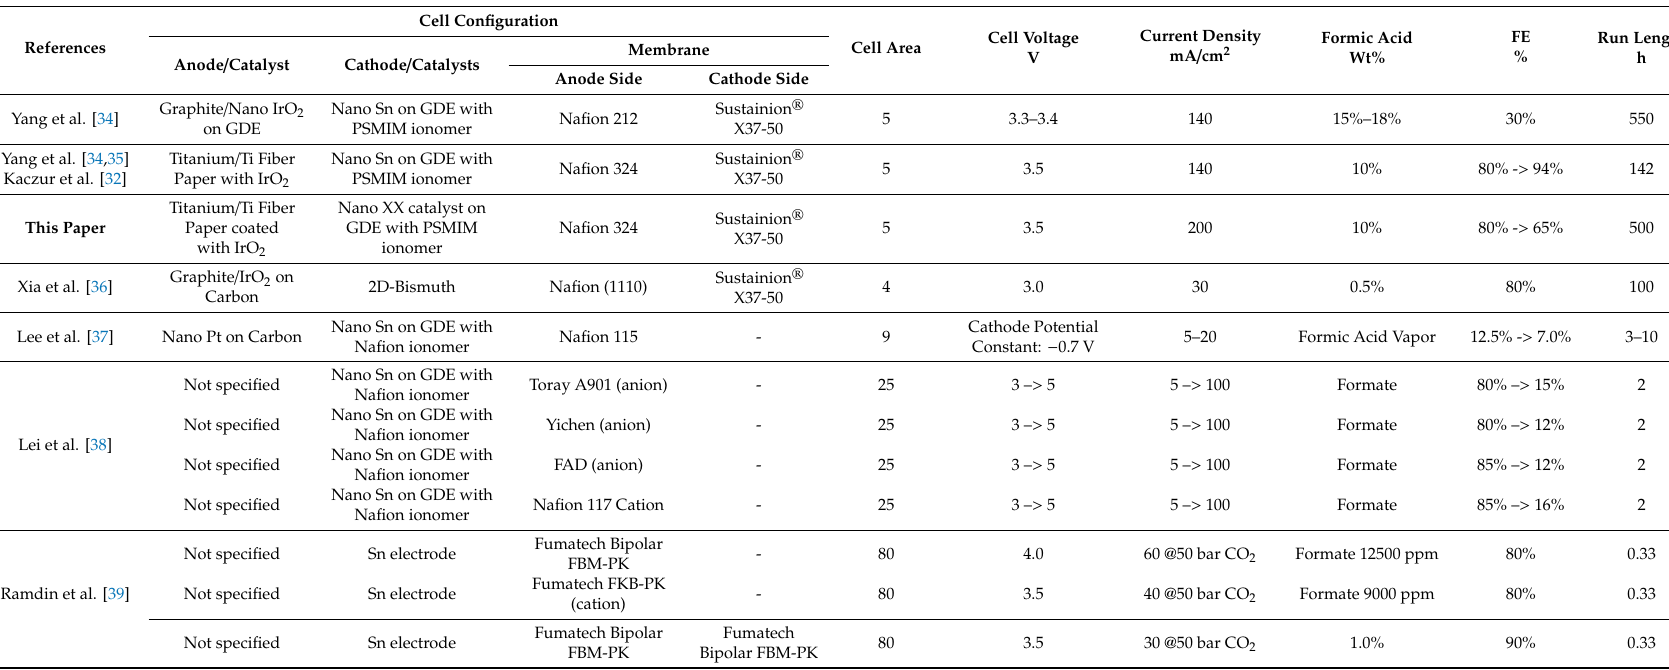
Table 2. A selection of data comparing the electrolysis of CO 2 and H 2 O to formic acid / formate using Sustainion ® anion membranes and other membrane